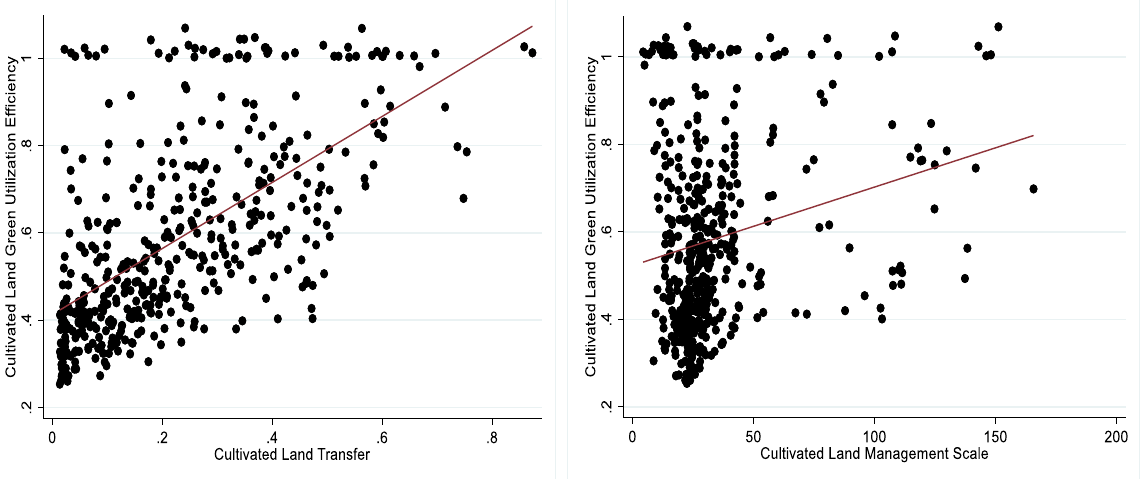
Figure 6. Linear Fitting Diagram. Note: The red line is a linear trend line fitted from all the scatter points.